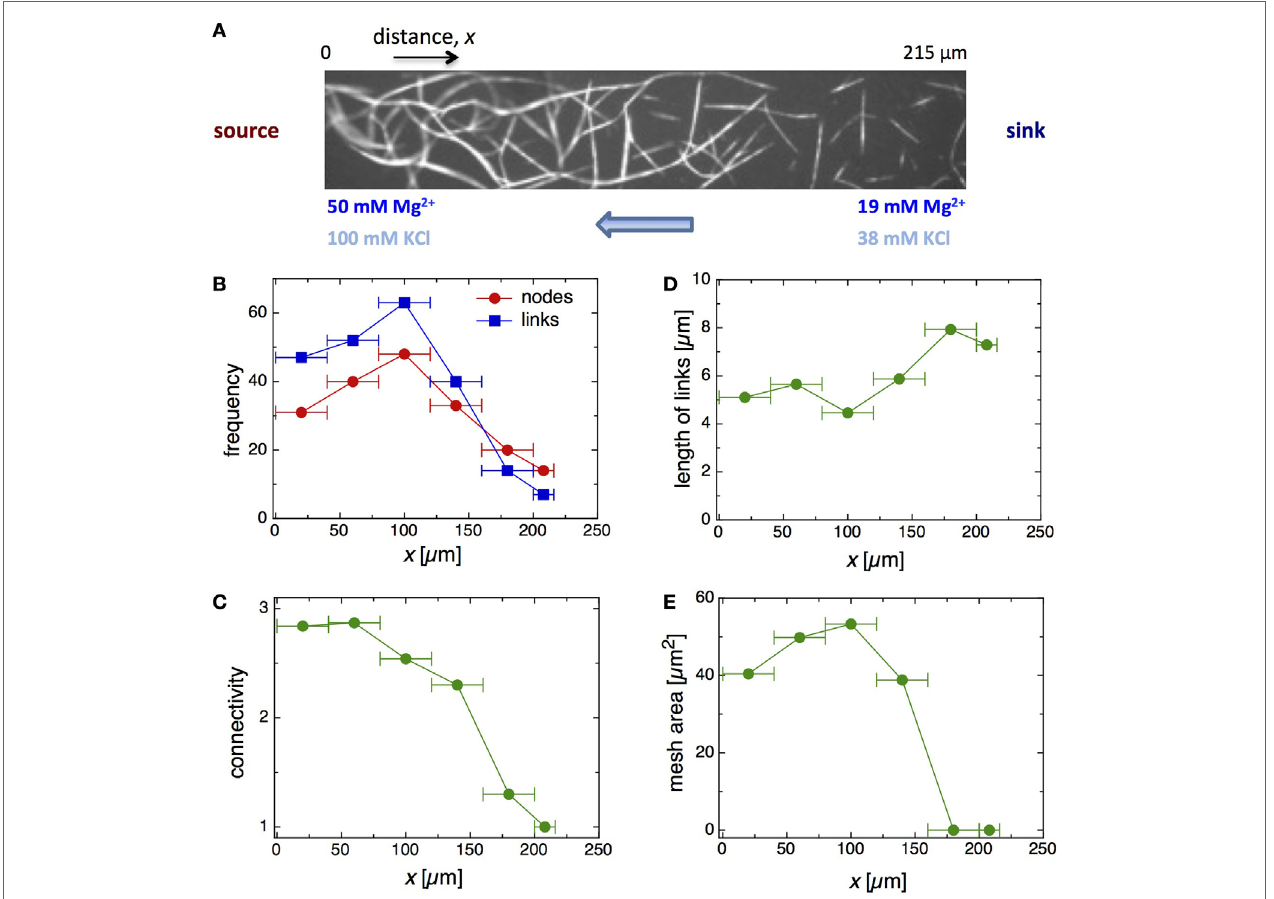
FigUre 4 | (a) Fluorescence micrograph of the formation of an Mg 2 + -induced F-actin bundle network in a double gradient of KCl and Mg 2 + . Several network properties are plotted against the x -position along the concentration gradients including the frequency of nodes and links (B) , the network connectivity (c) , the length of links (D) , and the mesh area (e)